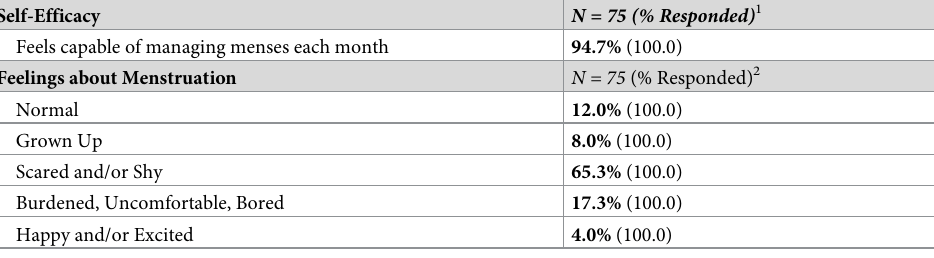
Table 4. Girls’ reports of self-efficacy and feelings during menstruation.